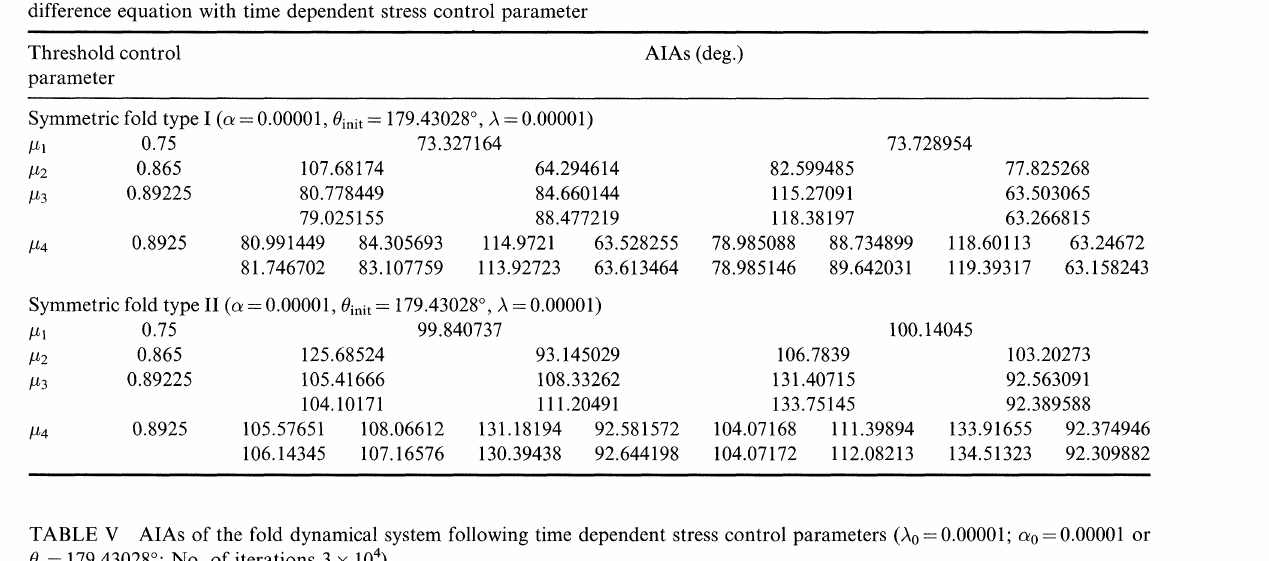
At + 4#At(1 t) AIAs Attractor time dependent stress control parameters (A*)